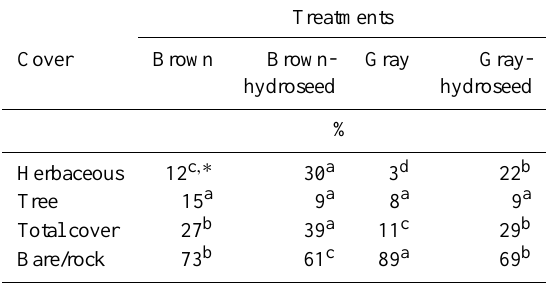
Table 3. Mean tree volume index 1 for 2008–2012 growing seasons in four soil treatments at the Arch–Birch River mine in Webster County, WV (Wilson-Kokes et al., 2013b).